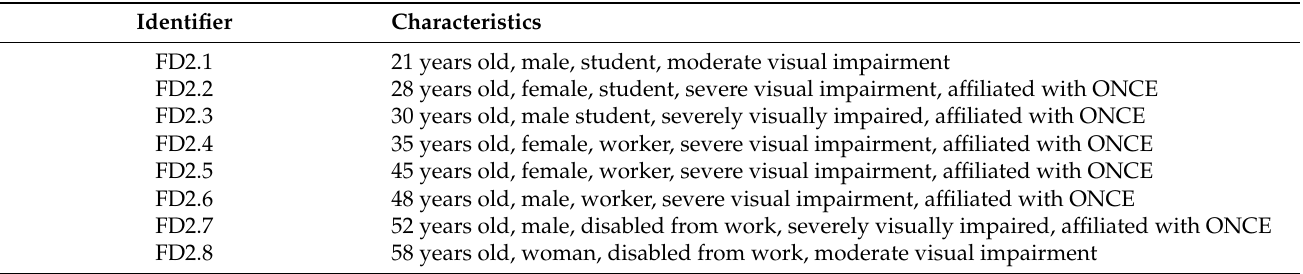
Table 2. Participants and characteristics of Focus Group